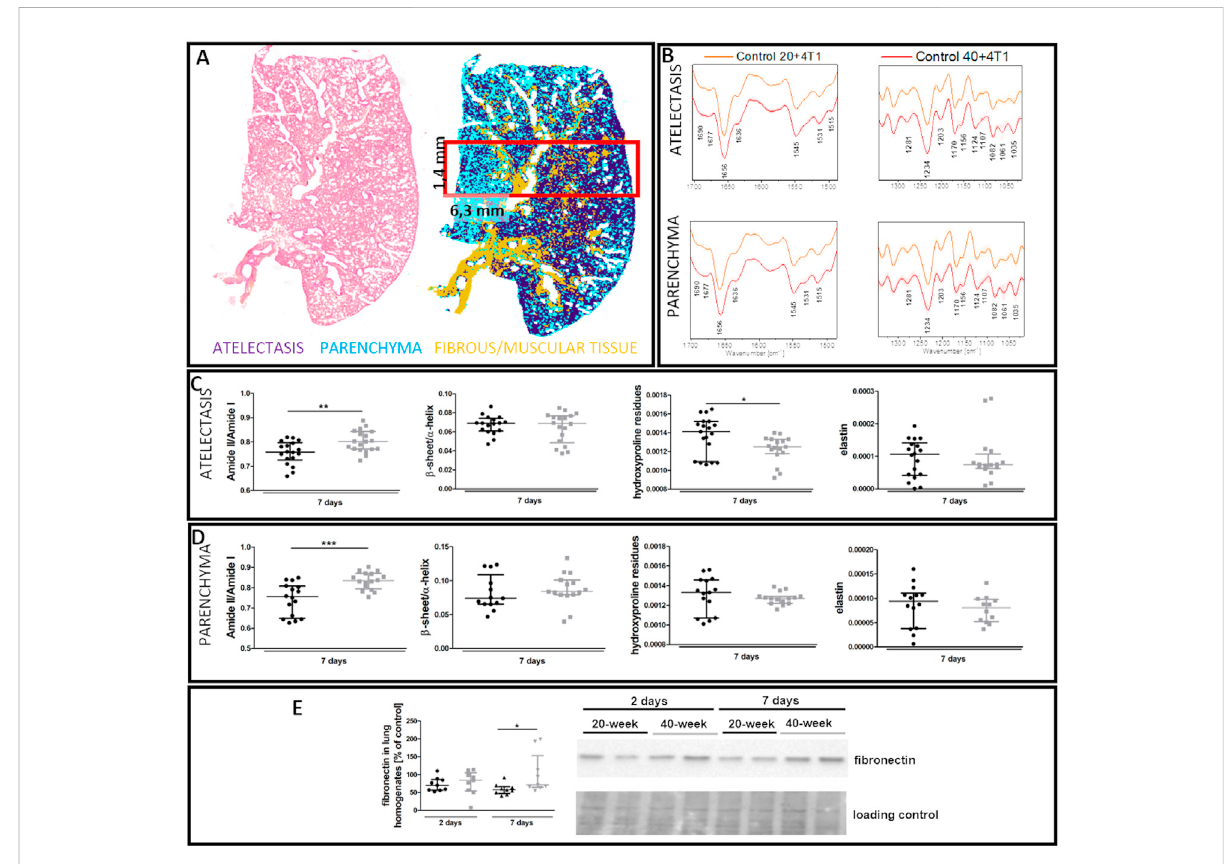
FIGURE 10 Lung ECM remodelling in 4T1 breast cancer cell-injected 20-week-old and 40-week-old BALB/c mice. Black symbols denote 20-week-old mice, and grey symbols denote 40-week-old mice. (A) Comparison of H&E staining and the false-colour cluster map of IR image showing differentiation of main morphological lung structures. (B) Averaged second derivative FTIRspectra (±SD) of each group. A semi-quantitative analysis of biomoleculesin the (C) atelectasis ( n = 14 – 20) and (D) lung parenchyma( n = 12 – 16), and (E) fi bronectin levels in thelung homogenates ( n = 9 – 10) are shown by representative western blot. Integration regions: Amide II/I [(1589 – 1485 cm − 1 )/(1707 – 1608 cm − 1 )], β -sheet/ α -helix [(1640 – 1623 cm − 1 )/(1670 – 1640 cm − 1 )], hydroxyproline residues (1187 – 1140 cm − 1 ), and elastin (1070 – 1040 cm − 1 ). Data are presented as dot plots with the median and IQR. Amide II/I and β -sheet/ α -helix in atelectasis (C) and amide II/I, β -sheet/ α -helix, hydroxyproline residues, and elastin in the parenchyma (D) were compared with an unpaired Student t -test. Hydroxyproline residues and elastin in atelectasis were compared with a Mann- Whitney U test (C) or two-way ANOVA (E) . Key: * p < 0.05; ** p < 0.01; *** p <